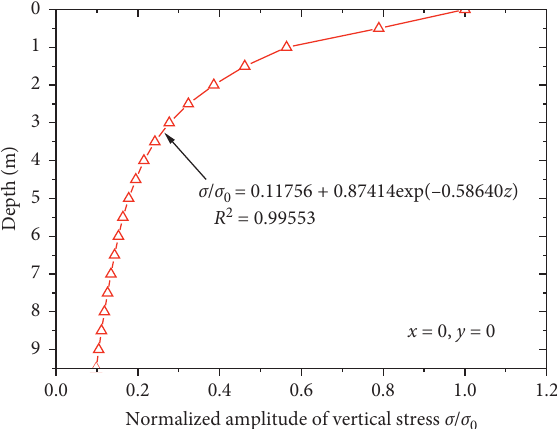
Figure 11: Variation of soil stress amplitude with depth in subgrade.